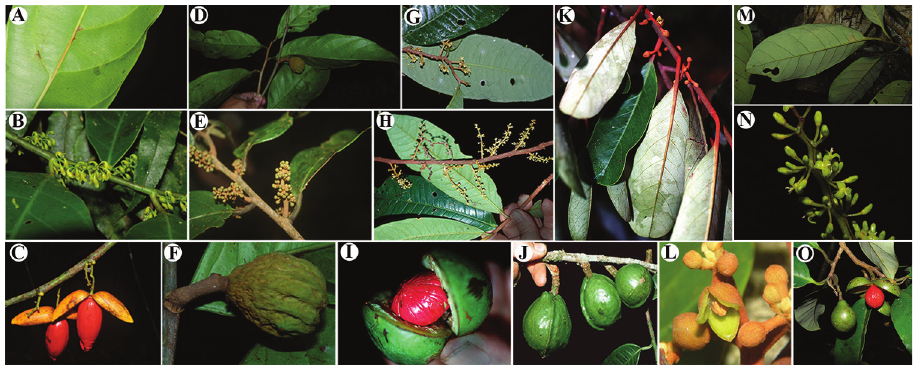
Leaf blades with tertiary veins conspicuous and more or less parallel and per- pendicular to the lateral veins............................... Compsoneura (Fig. 1A–F) – Leaf blades with tertiary veins inconspicuous or, when conspicuous, not as above .......................................................................................................... 2 Leaf blades with malpighiaceous trichomes on abaxial surface ..................... 3 – Leaf blades with stellate, dendritic, or irregularly stellate trichomes on abaxial surface ........................................................................................................ 4 3 Vernation convolute; abaxial surface of leaf blades without hyaline crystals; flowers with bracteoles; fruits transversally ellipsoid, if globose, the pericarp 7–8 mm thick; seeds not gibbose at the apex ............ Iryanthera (Fig. 1G–J) – Vernation conduplicate; abaxial surface of leaf blades with hyaline crystals; flowers without bracteoles (in Mesoamerica); fruits longitudinally globose to subglobose; seeds usually gibbose near the apex ............ Otoba (Fig. 1M–O) 4 Trichomes on abaxial leaf surface stellate, concolorous; inflorescences sessile, with 1–2 (–3) main branches; flowers with bracteoles; stamens 10 (in Mesoa- merica); fruits transversally ellipsoid .................... Osteophloeum (Fig. 1K–L) – Trichomes on abaxial leaf surface dendritic, irregularly stellate or if stellate, the central part of the trichome reddish to reddish-clear, constrasting in col- our with the hyaline branches; inflorescences distinctly pedunculate, with 1 main branch; flowers without bracteoles; stamens 3–7; fruits ellipsoid, glo- bose, ovoid or subglobose ................................................................... Virola